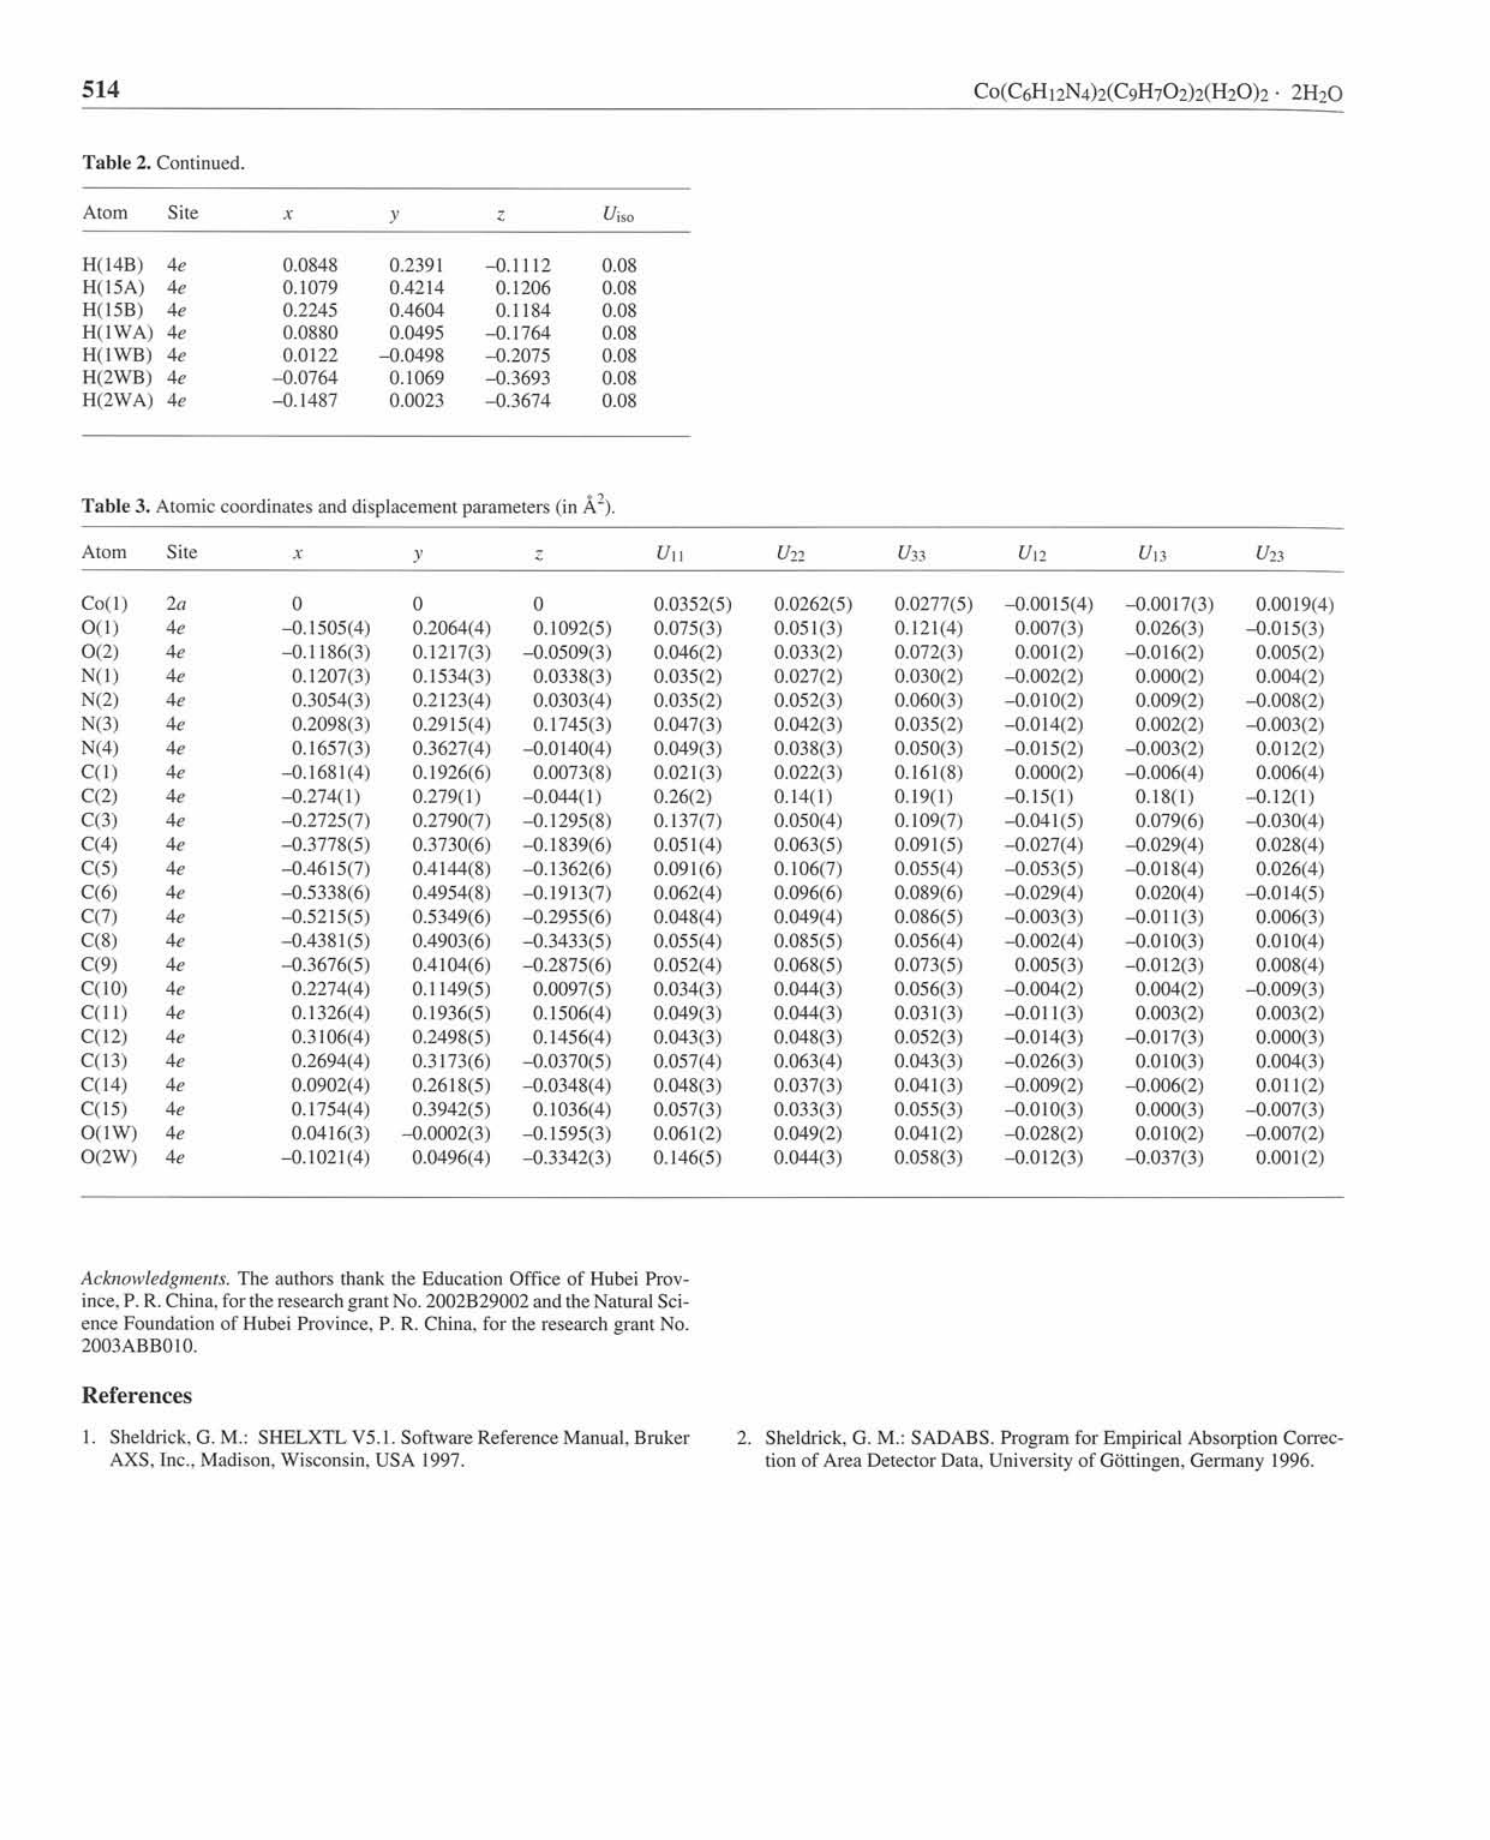
Table 3. Atomic coordinates and displacement parameters